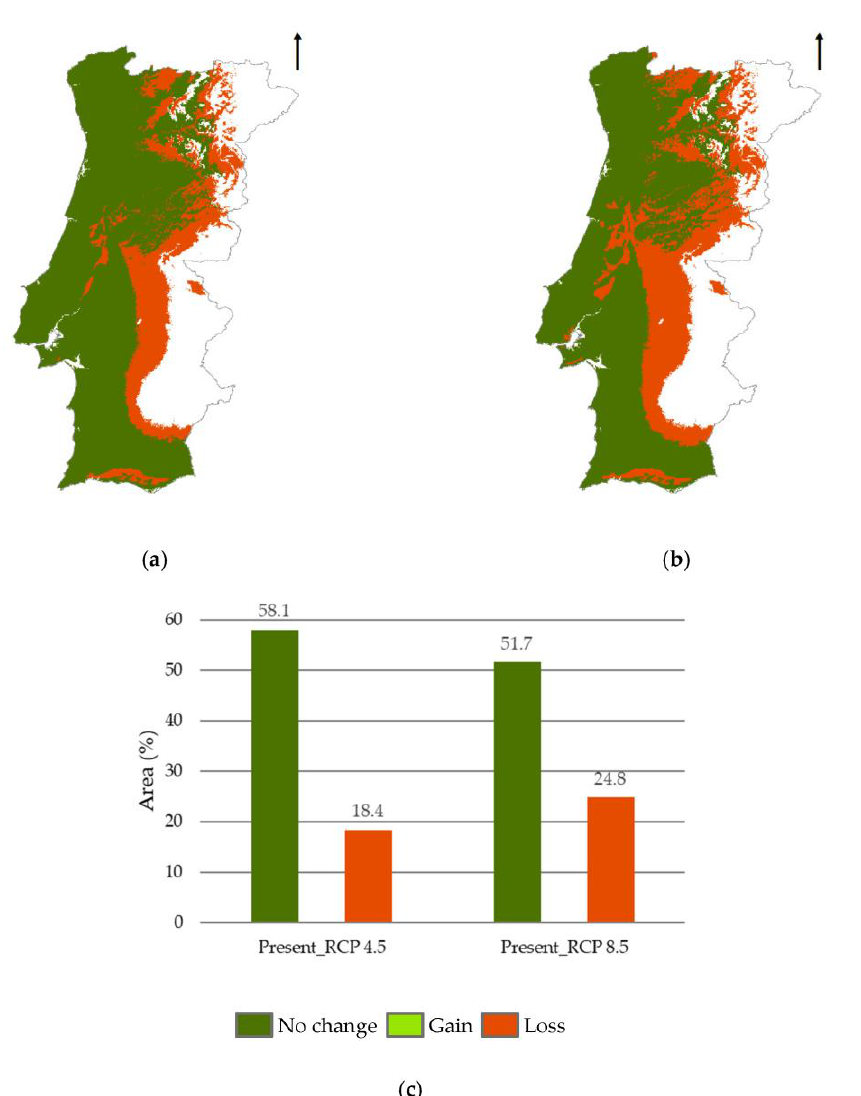
Figure 9. Ecological envelope—Maritime pine distribution area changes under the climate change scenarios: ( a ) Present to future 2070 under RCP 4.5 climate change scenario; ( b ) Present to future 2070 under RCP 8.5 climate change scenario; and ( c ) No change, gains, and losses areas (%) between present and future.